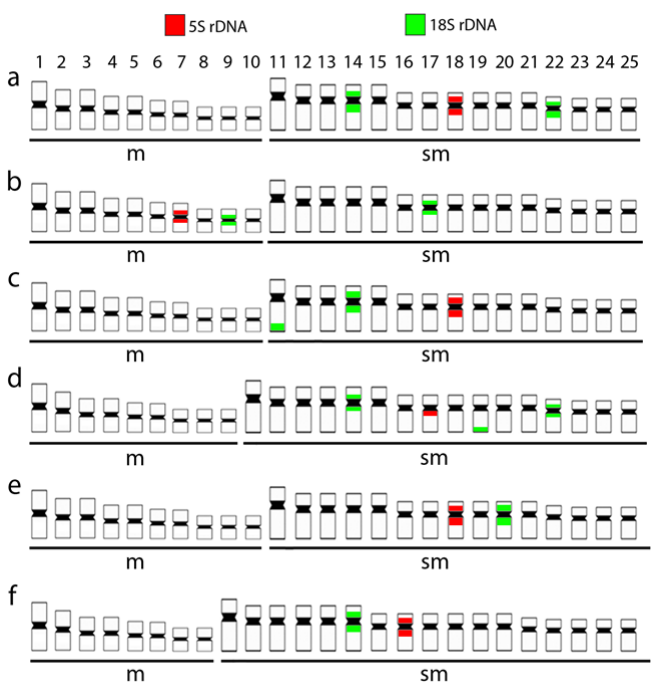
Figure 6. Representative idiograms of ( a ) Hoplias aimara ; ( b ) H. australis; ( c ) H. brasiliensis ; ( d ) H. curupira ; ( e ) H. intermedius ; and ( f ) H. lacerdae highlighting the distribution of 18S (green) and 5S (red) rDNA sequences on the chromosomes.